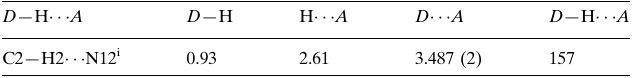
Hydrogen-bond geometry (A˚ , (cid:2) ).